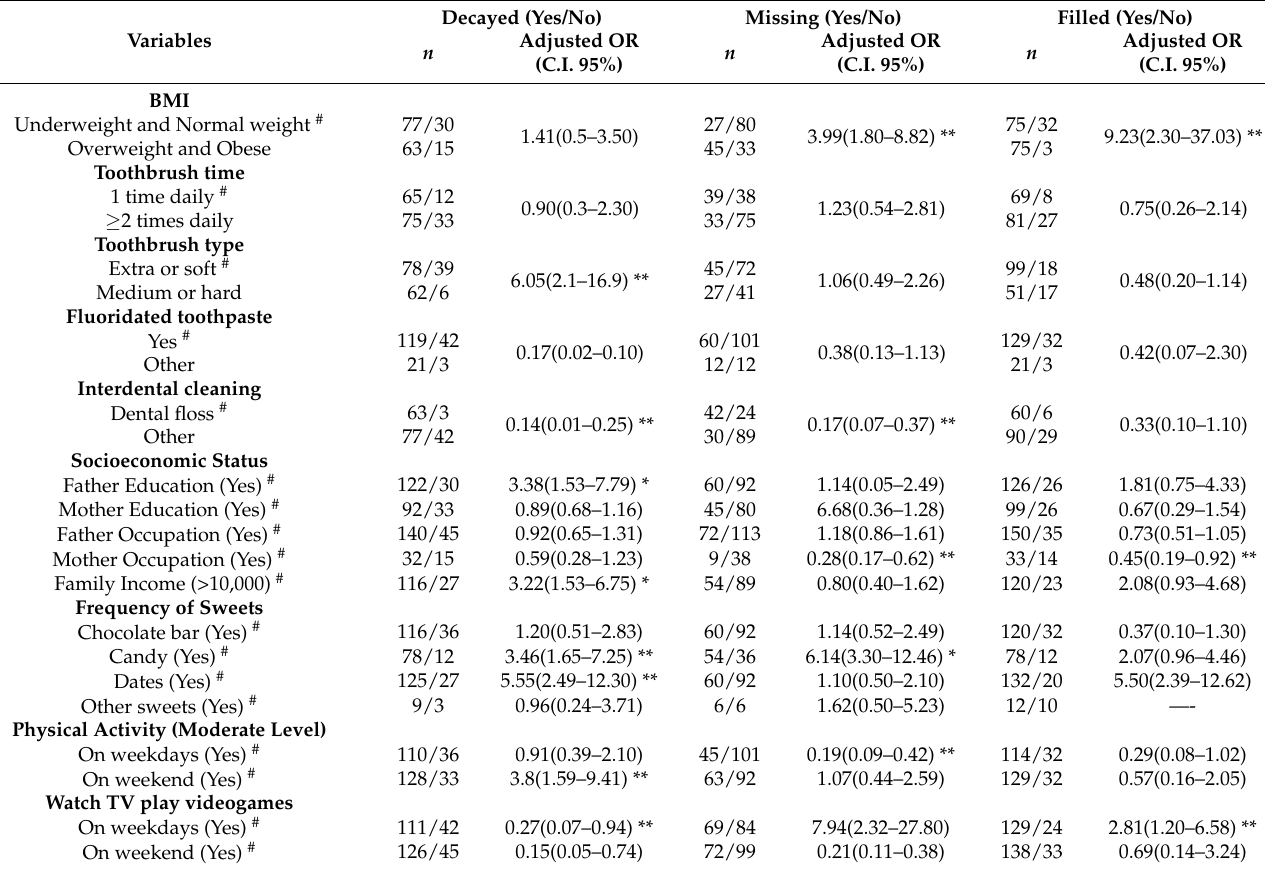
Table 5. Association between BMI, tooth brushing time, toothbrush type, use of fluoridated toothpaste, interdental cleaning and decayed (yes/no), missing (yes/no), and filled teeth (yes/no)